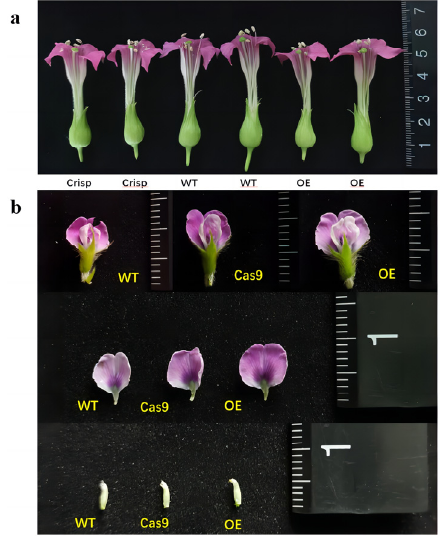
Figure 9. Phenotypic analysis of GmAP3 transgenic plants. The score value of the scale ruler is 1 mm. ( a ) Morphological map of floral organs in transgenic and wild-type tobacco; ( b ) comparison of flower organs between transgenic and wild-type soybean.